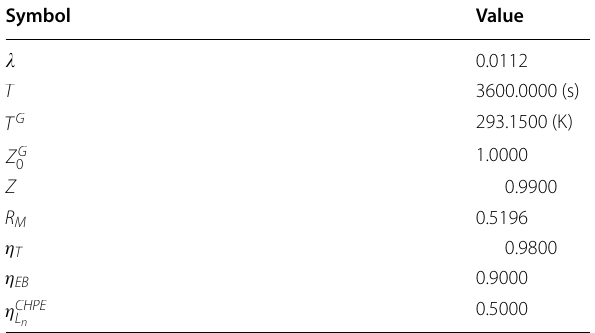
Table 1 Constant parameters